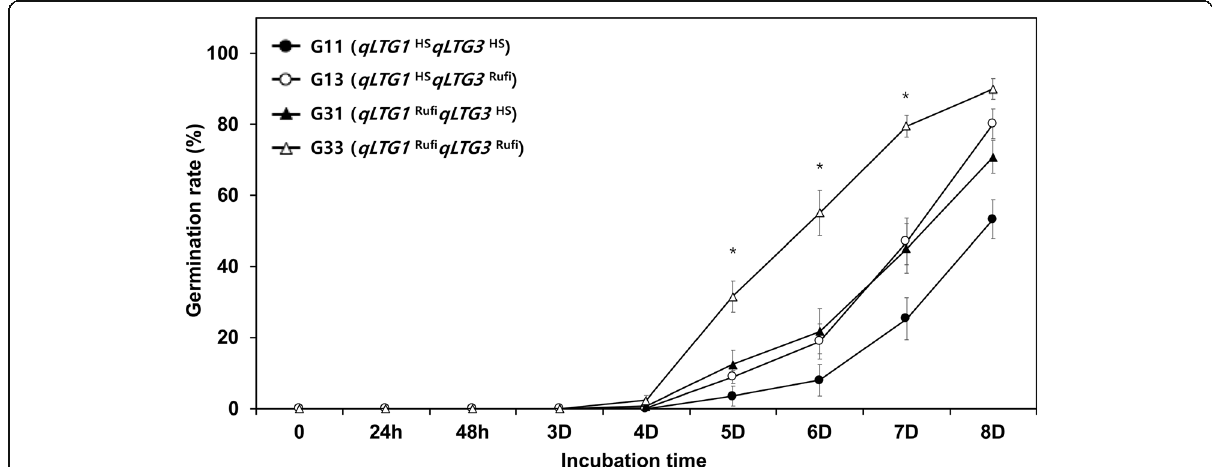
Fig. 2 Comparison of the germination rates of the four genotype groups at 13 °C. qLTG1 HS and qLTG1 Rufi indicate homozygosity for Hwaseong and O. rufipogon genotype at the qLTG1 locus, respectively. qLTG3 HS and qLTG3 Rufi indicate homozygosity for Hwaseong and O. rufipogon at the qLTG3 locus. * indicates a significant difference of P < 0.05 based on ANOVA. Error bars indicate standard